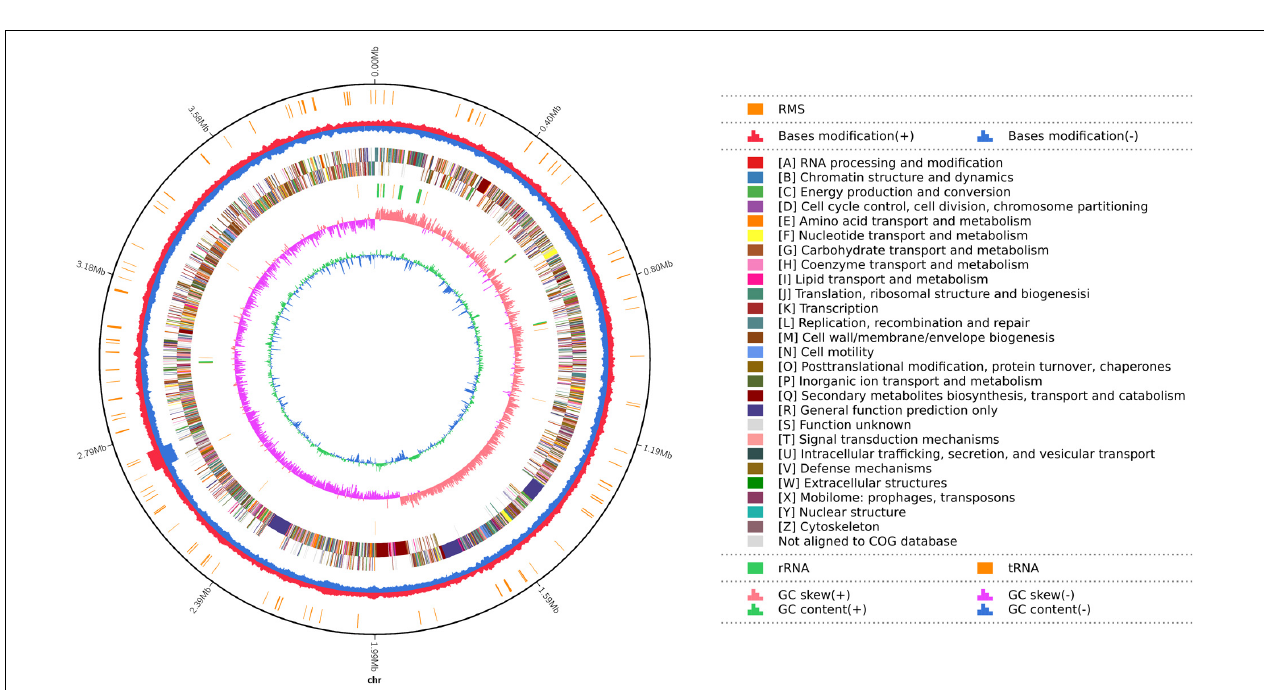
FIGURE 3 | Morphology of strain YB-130. (A) Colony morphology of strain YB-130 on NA; (B) Gram staining of strain YB-130; (C) Scanning electron microscopy (SEM) images of strain YB-130.